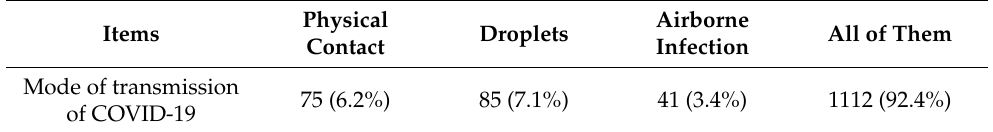
Table 5. The cognition of COVID-19 infection mode (multiple